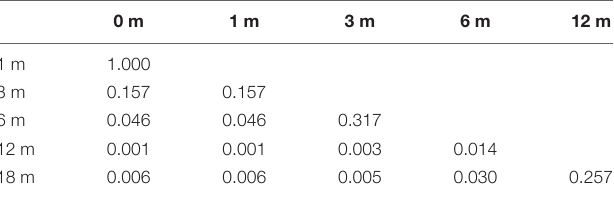
TABLE 5 | Comparison of the Speech Intelligibility Rating (SIR) scores for each time point in the common cavity deformity (CCD)